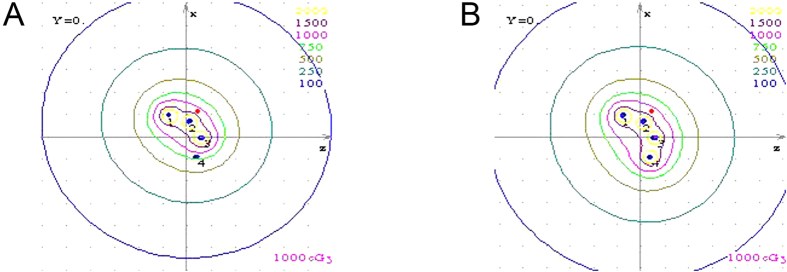
Isodose distribution in transverse section for 252-Cf treatment plan.The reference points were the red points, and was defined on the surface of the mucosa. (A) Three channels of the applicator; (B) Four channels of the applicator.